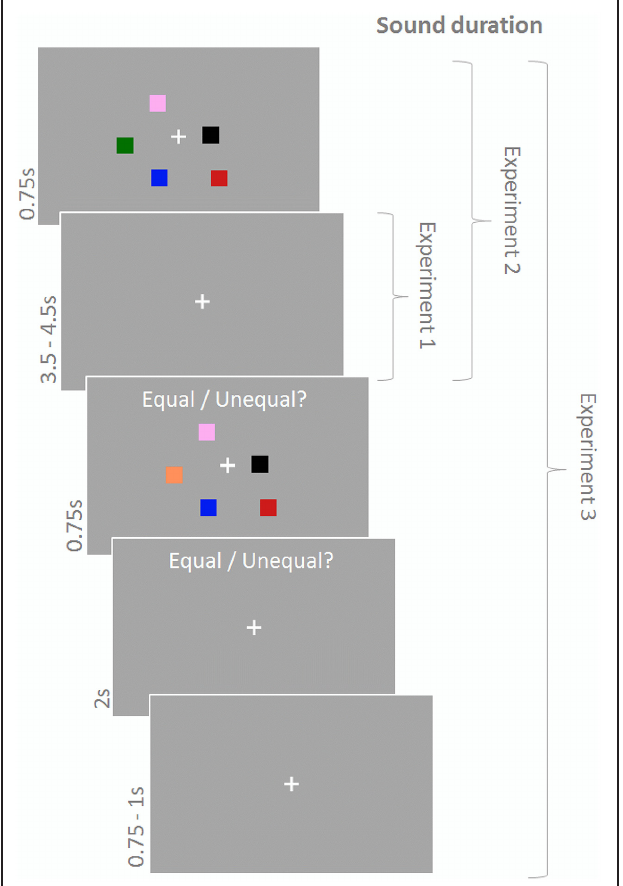
FIGURE 1 | Change detection task. Participants had to indicate whether the test array differed from the memory array. Sound was presented during the maintenance period in Experiment 1, during encoding and maintenance in Experiment 2, and continously in Experiment